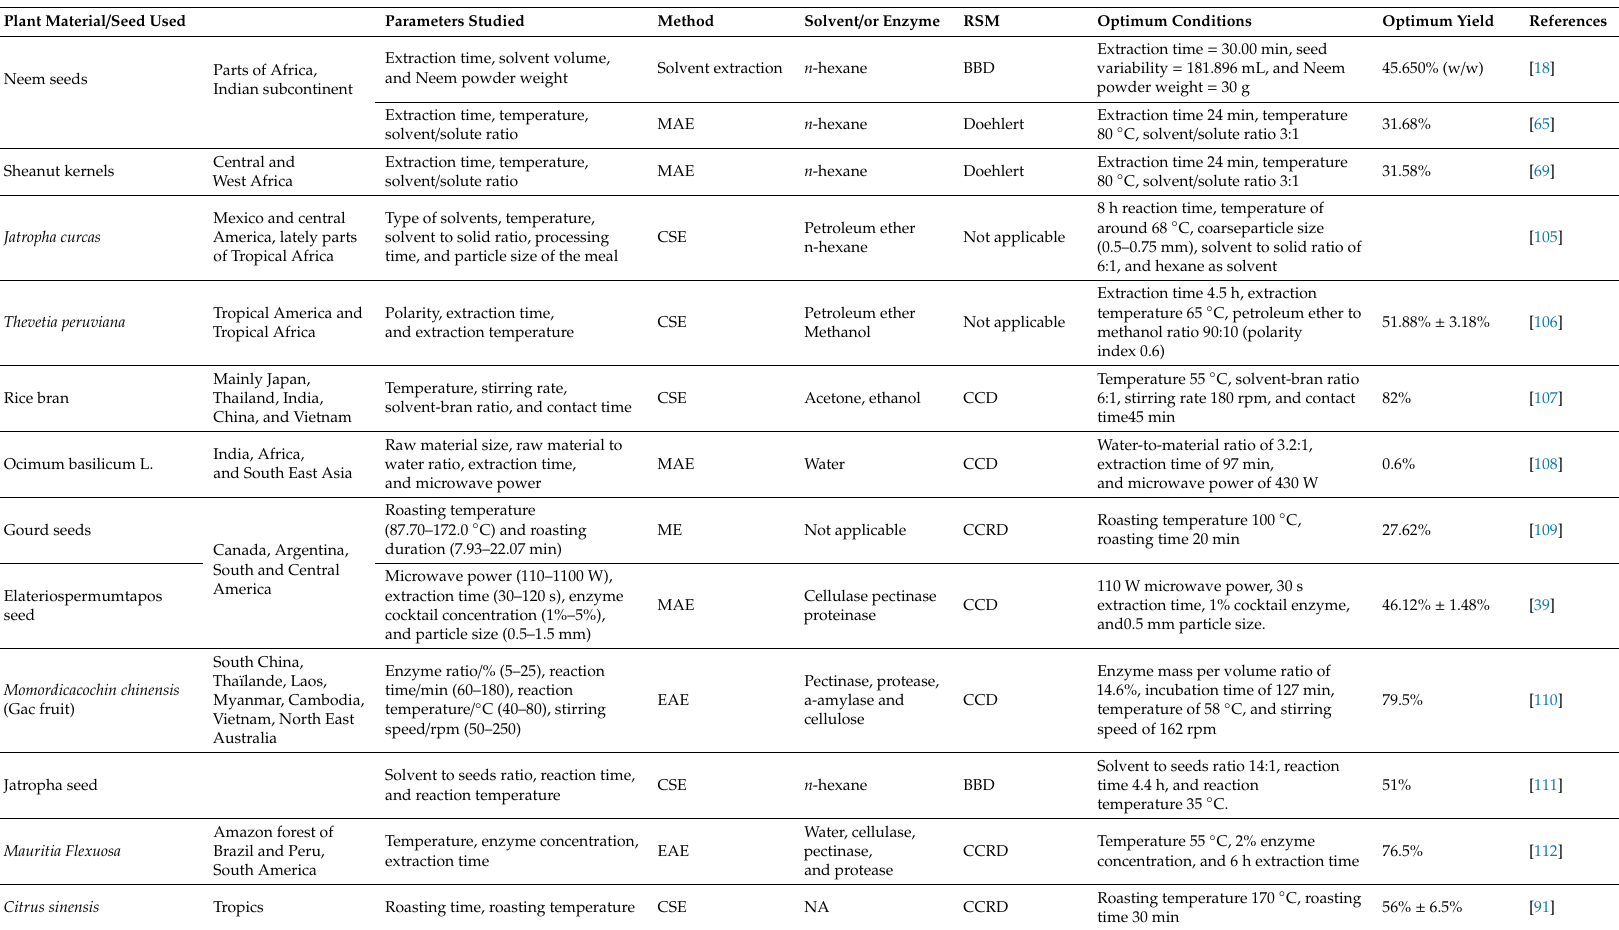
Table 1. Response Surface Methodology (RSM) parameters, type of oilseed, and solvent type on oil yield.